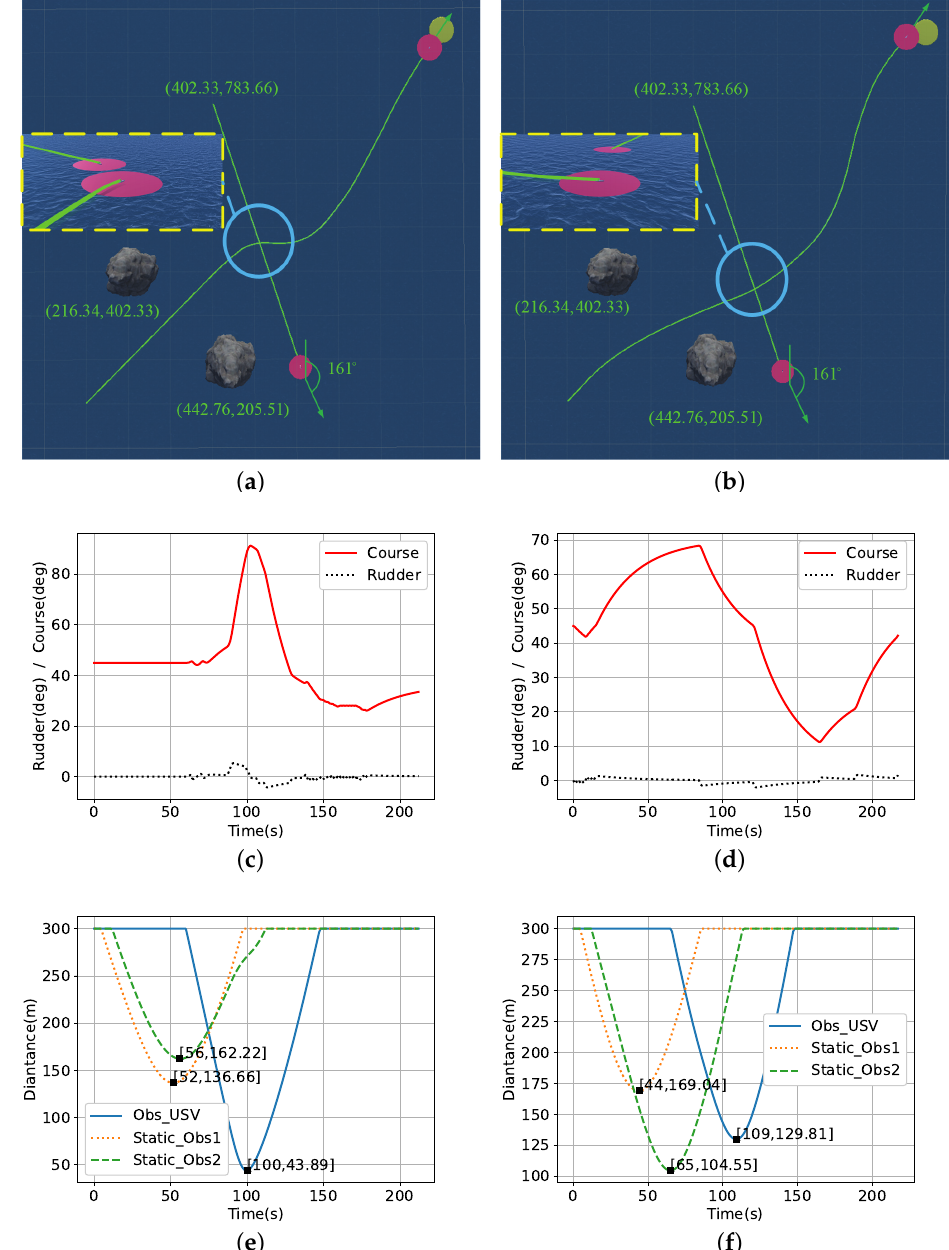
Figure 11. Encounter situation 1. ( a ) Path planned by DRLCA; ( b ) Path planned by DQN; ( c ) Course and rudder for DRLCA; ( d ) Course and rudder for DQN; ( e ) Distance for DRLCA; ( f ) Distance for